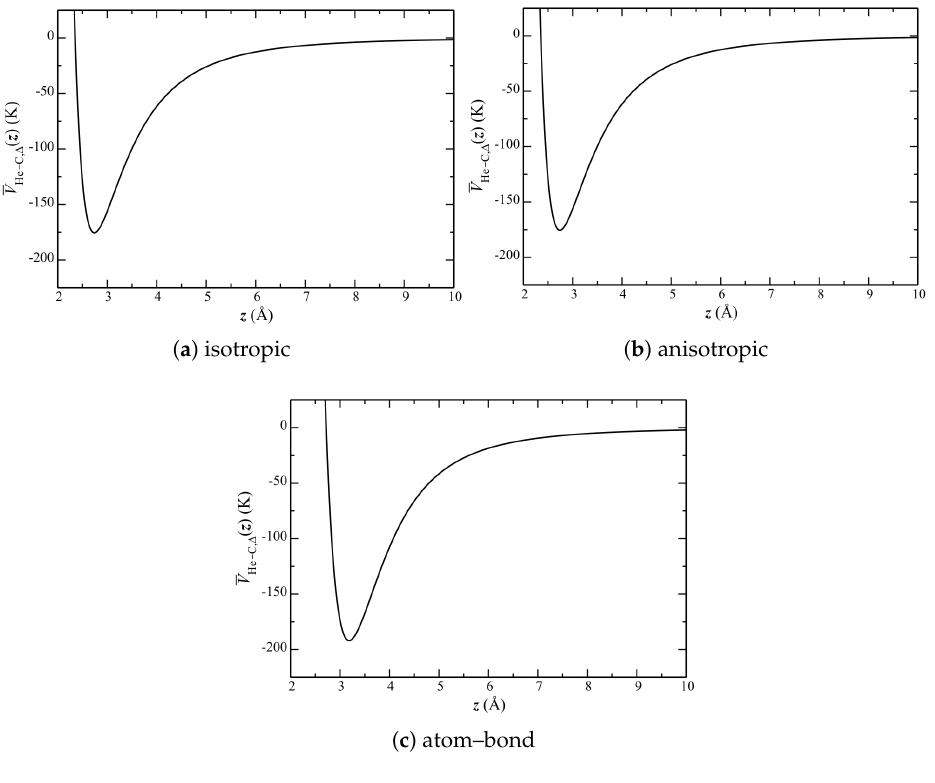
Figure 7. Lateral-averaged He–C potential V He–C, (cid:52) ( z ) .